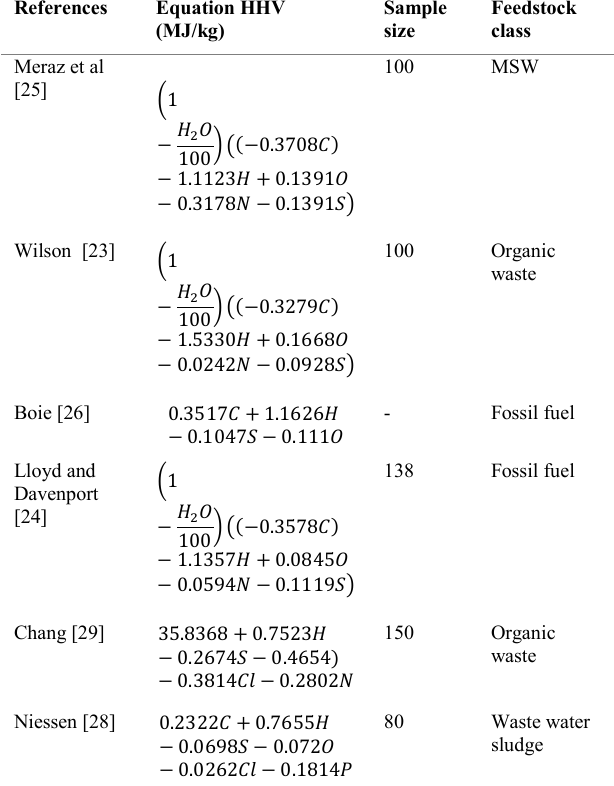
Table 1. Correlations for the prediction of